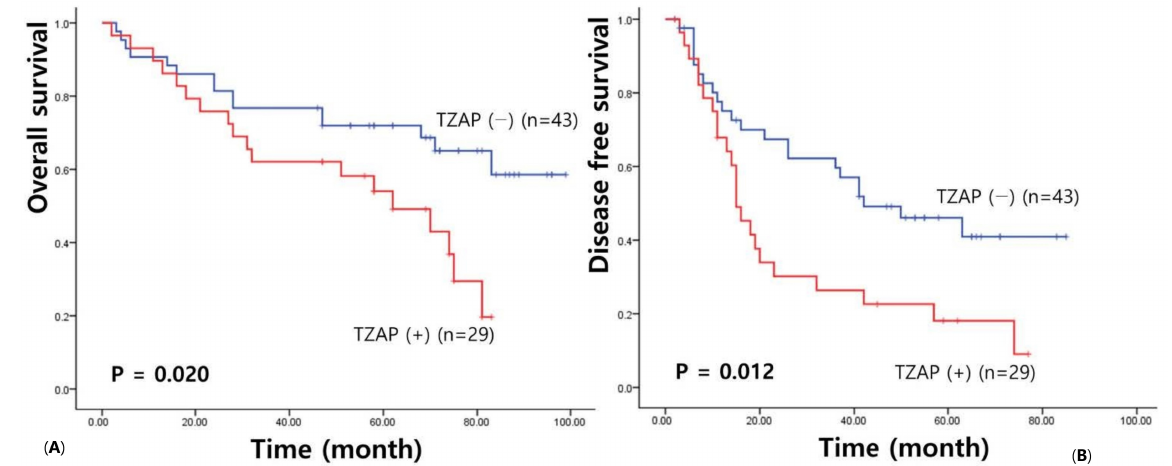
Figure 1. TZAP expression survival analysis in HCCs: ( A ) Overall survival; and ( B ) disease-free survival.